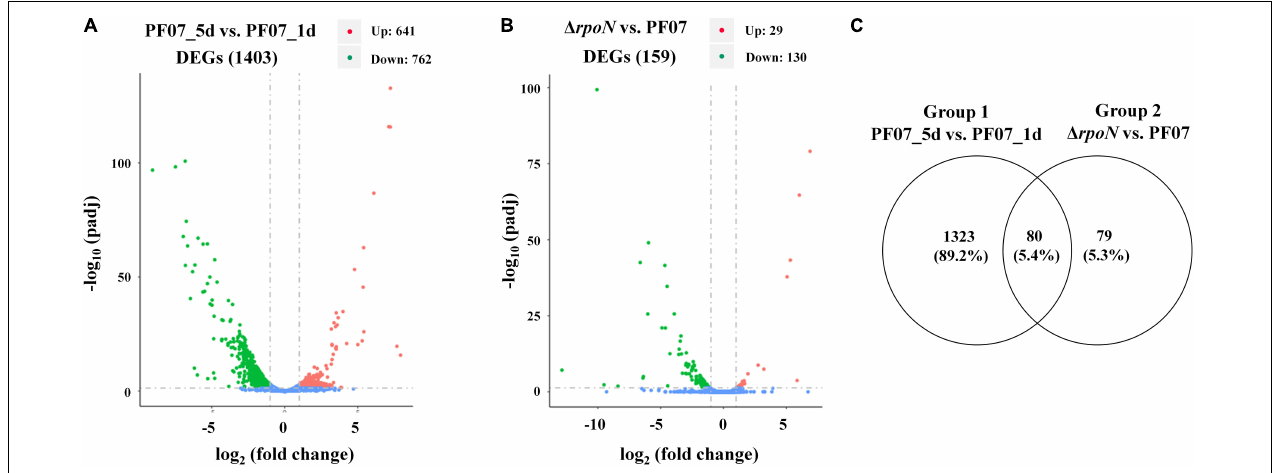
FIGURE 1 | DEGs from RNA-seq analyses. (A) DEGs between macrocolony biofilms of PF07_5d and PF07_1d (Group 1). (B) DEGs between macrocolony biofilms of (cid:49) rpoN and PF07 after 5 days of incubation (Group 2). The horizontal axis represents fold changes of gene expression, and the vertical axis represents the level of statistical significance. The red dots represent significantly upregulated genes, and the green dots represent significantly downregulated genes. (C) Venn diagram of Group 1 and Group 2. This figure was drawn using Venny 2.0.